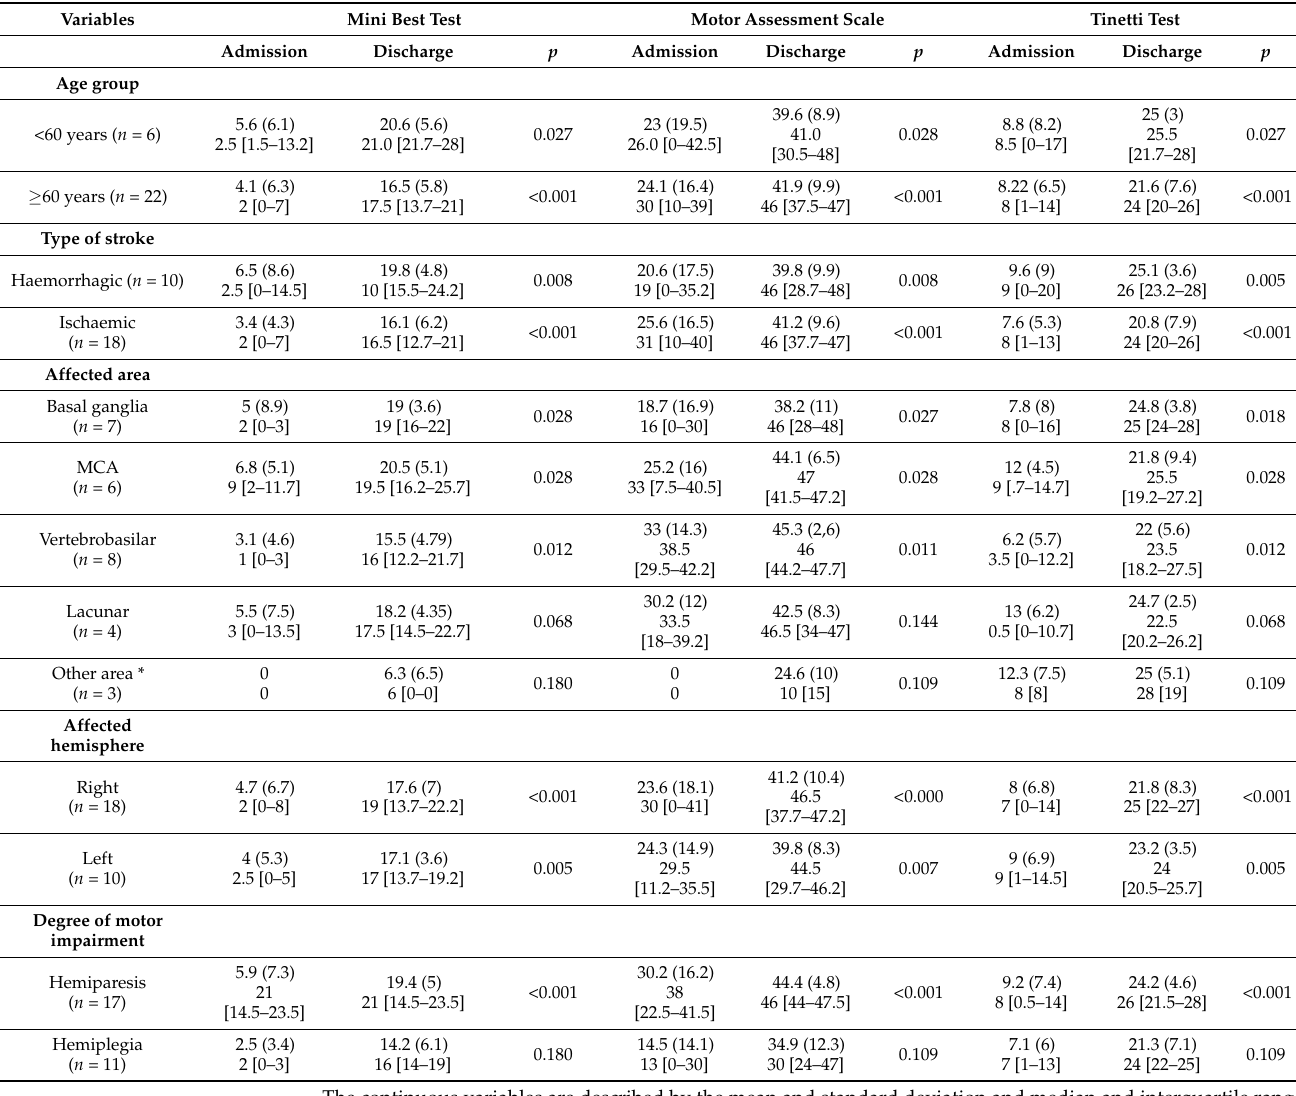
Table 2. Scores at admission and discharge for the Mini Best Test, the Motor Assessment Scale and the Tinetti Test by age, type of stroke, the area affected, the hemisphere affected and the degree of motor